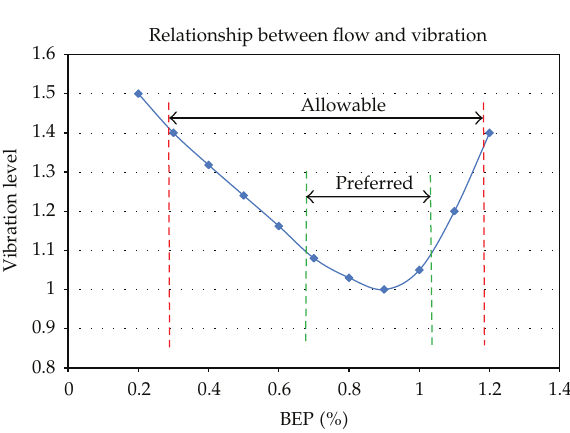
Figure 5: Idealized flow versus vibration plot recommended by API